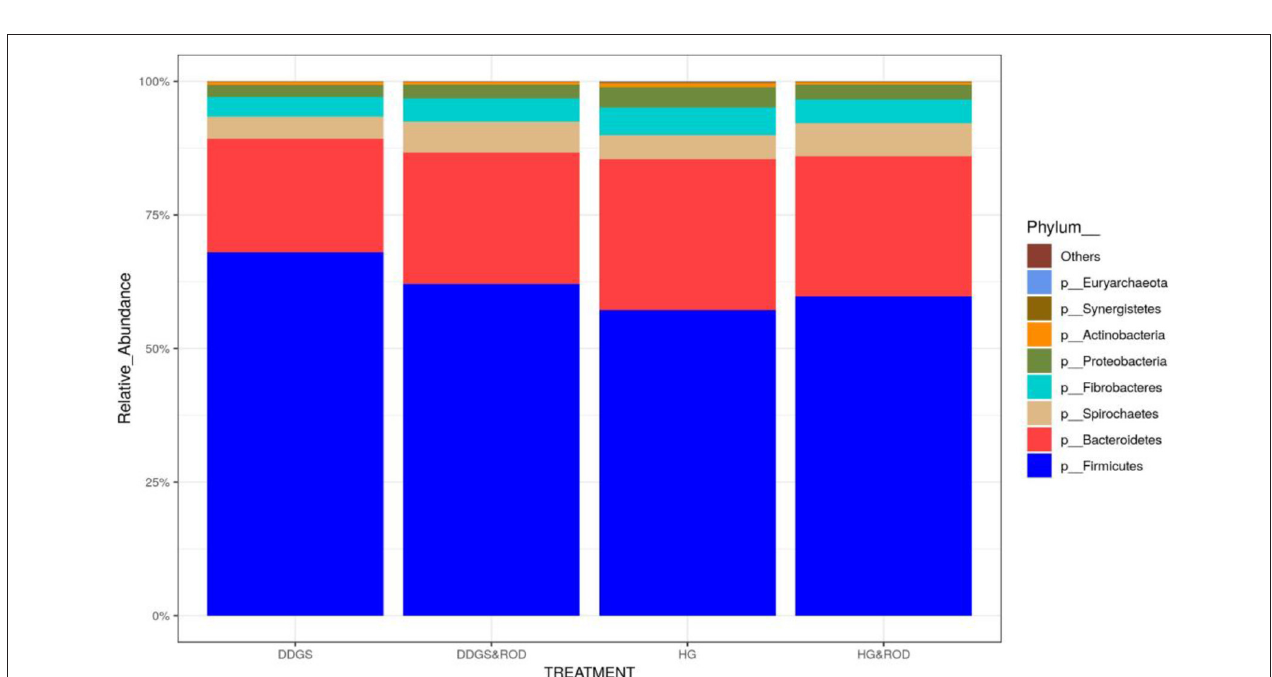
FIGURE 2 | Non-metric multidimensional scaling (NMDS) plots of the Bray–Curtis dissimilarities for FPA samples by treatment. Treatments were as follows: DDGS diet without adding the ROD extract; DDGS&ROD (wheat DDGS diet with ROD extract); HG (basal diet without adding ROD extract); and HG&ROD (basal diet with ROD extract).